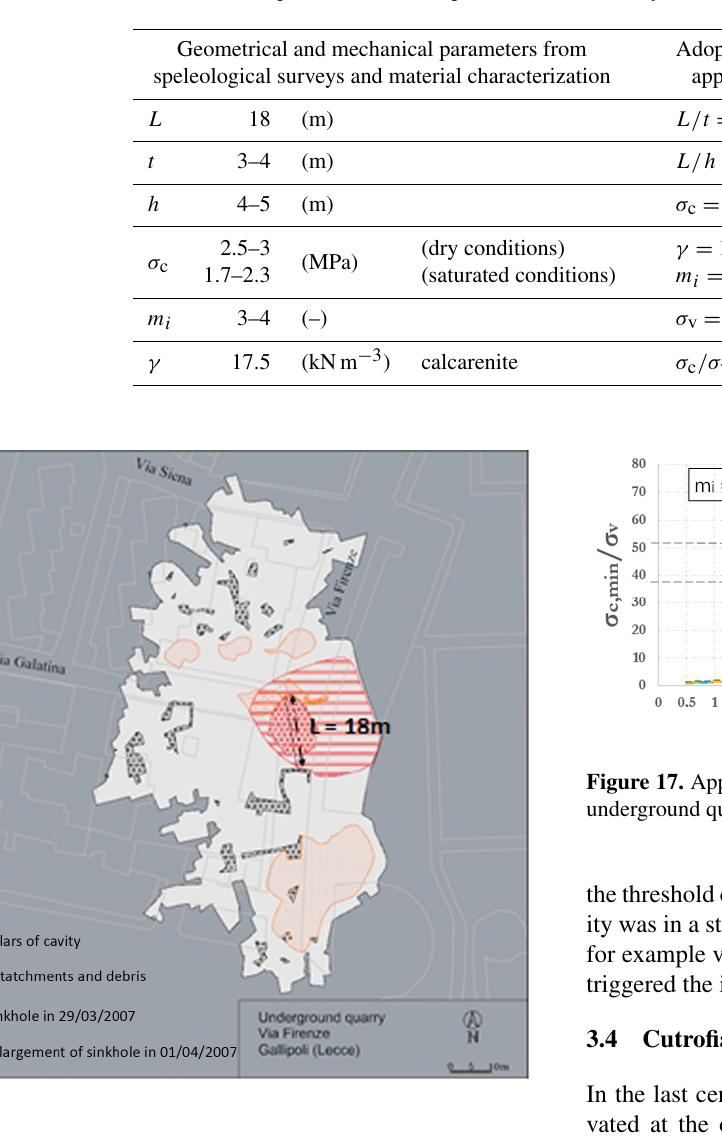
Figure 15. Map of the underground quarry in Via Firenze, Gallipoli, and overlying built environment.